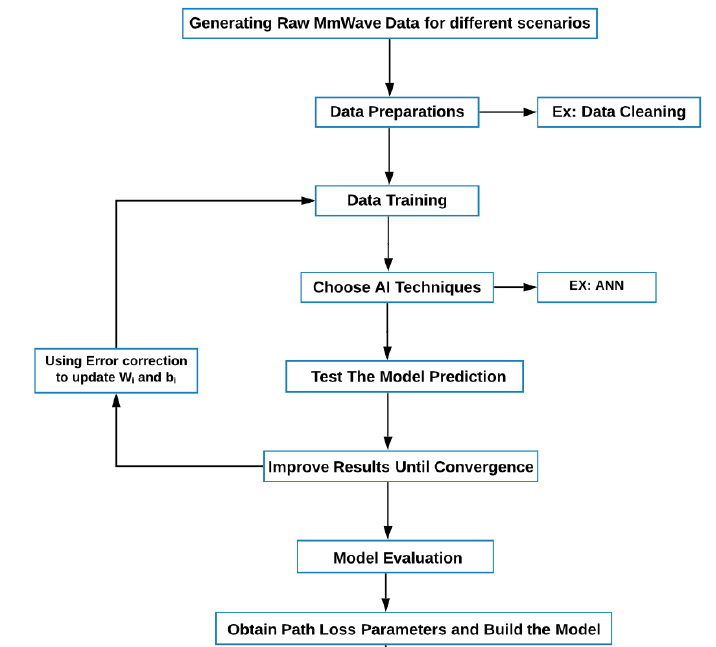
Figure 2. Flowchartof the proposed